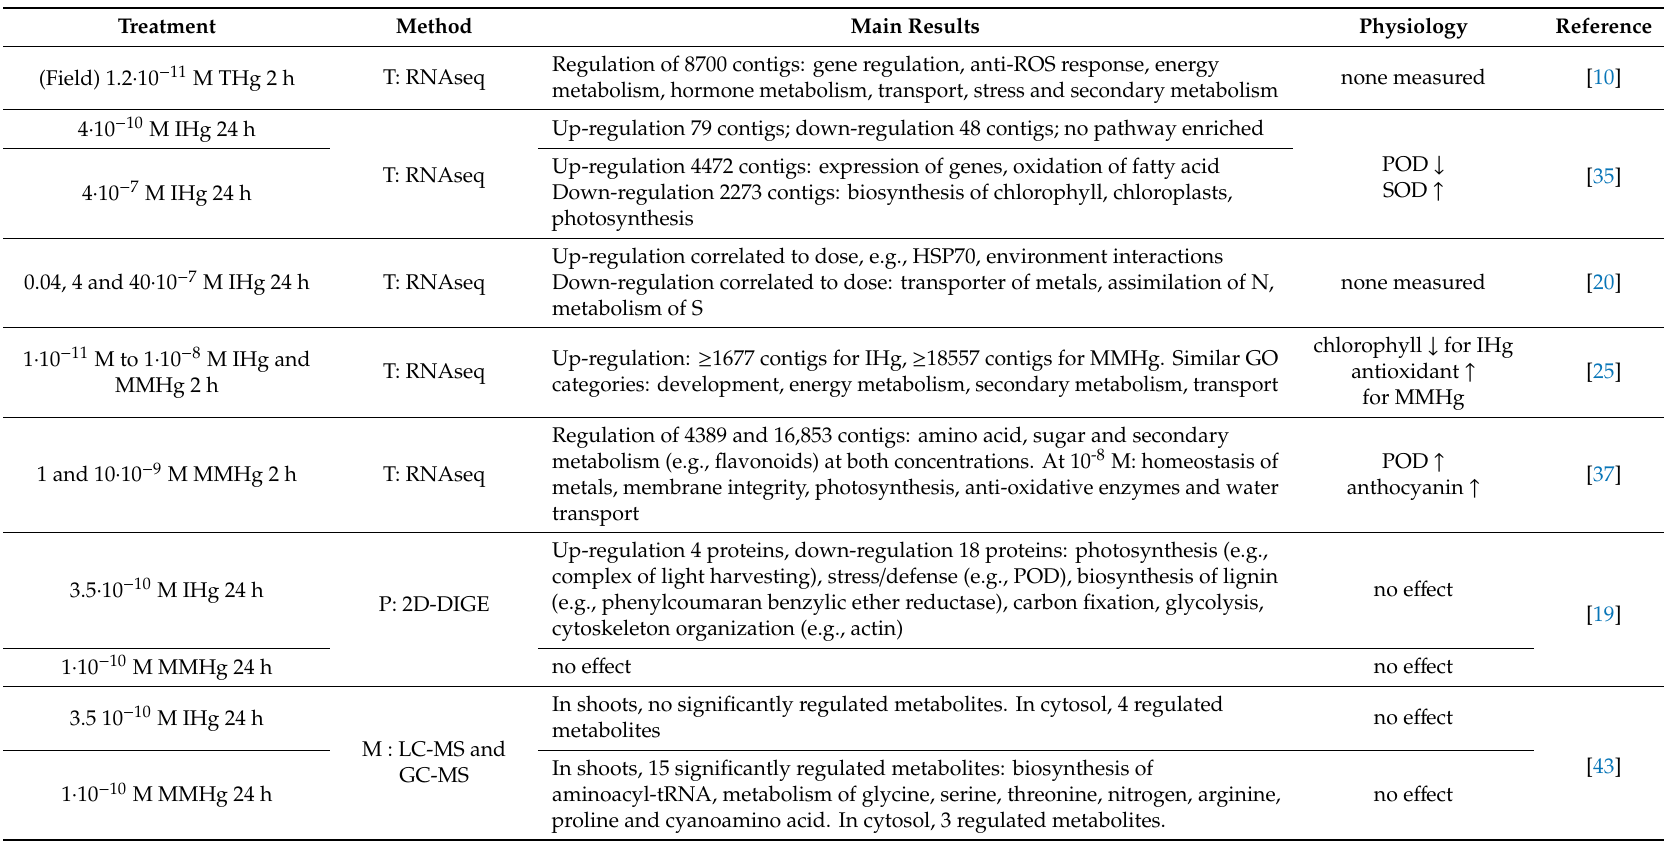
Table 1. Responses to Hg revealed by metabolomic (M), proteomic (P) or transcriptomic (T) in E.